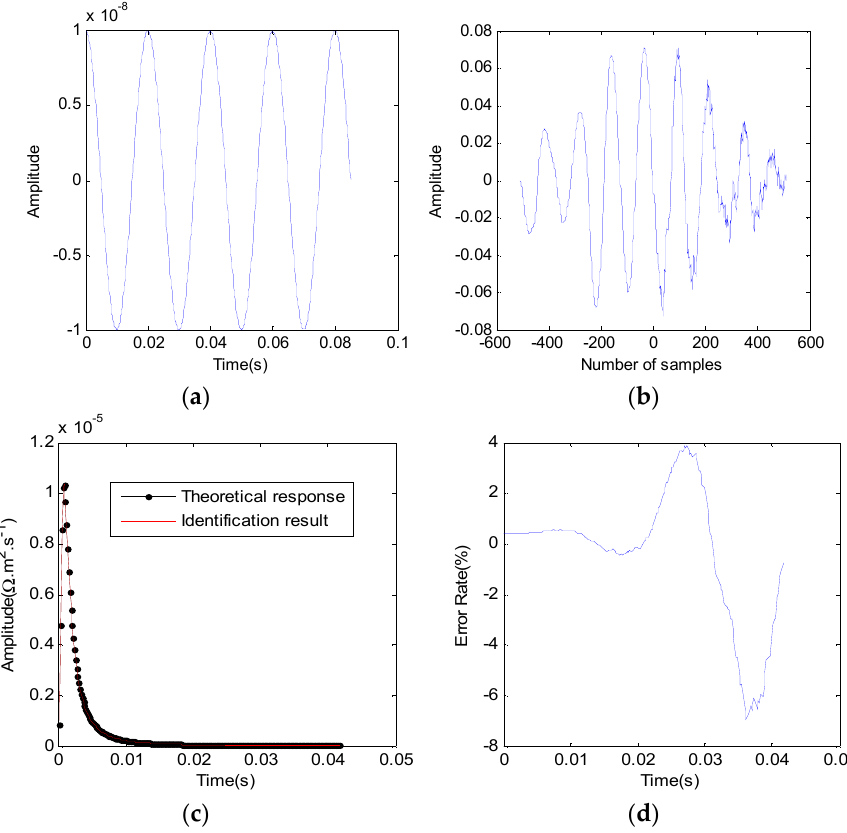
Figure 9. The earth impulse response extracted with sine-wave noise. ( a ) Sinusoidal noise signal; ( b ) cross-correlation of m-sequence and noise signal; ( c ) earth impulse response extraction result; ( d ) identification error.